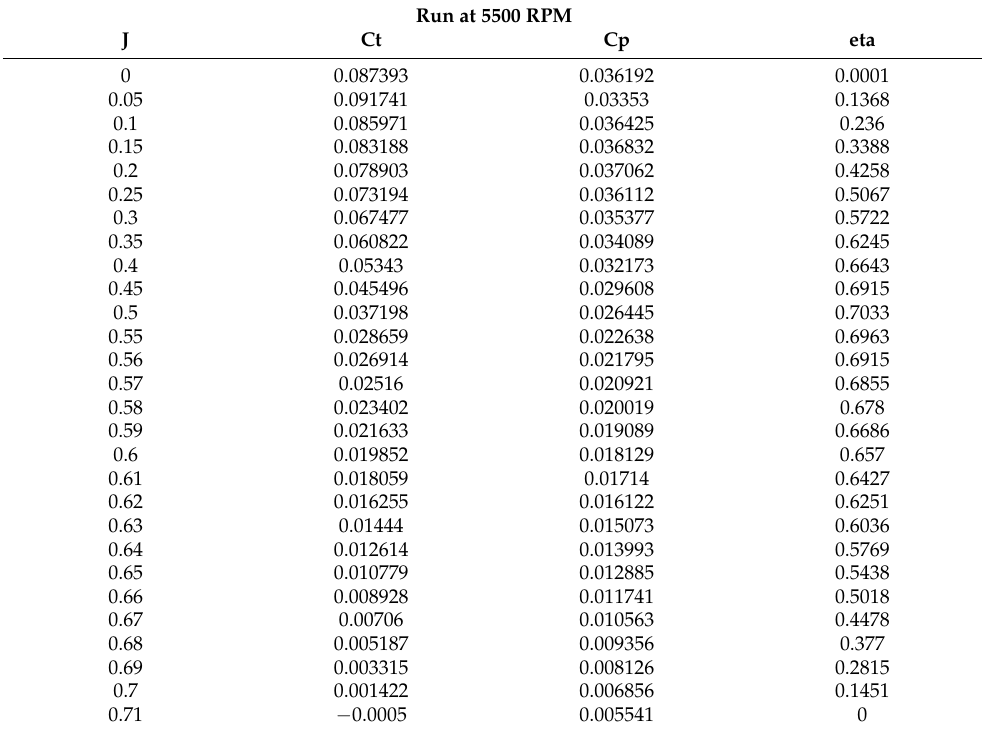
Table A24. BEMT 18 × 10 APC propeller